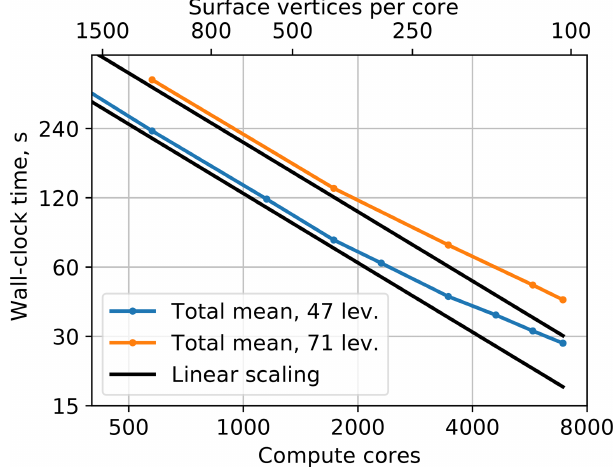
Figure 6. The fArc scaling on Mistral (DKRZ Hamburg) with stan- dard 47 layers (blue line) and 71 layers (orange